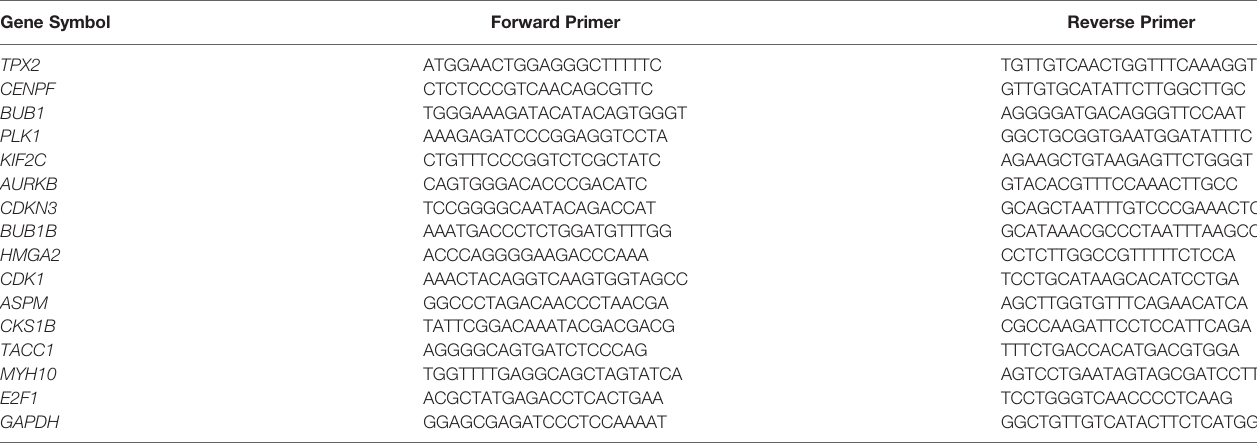
TABLE 1 | Primers used for qRT-PCR